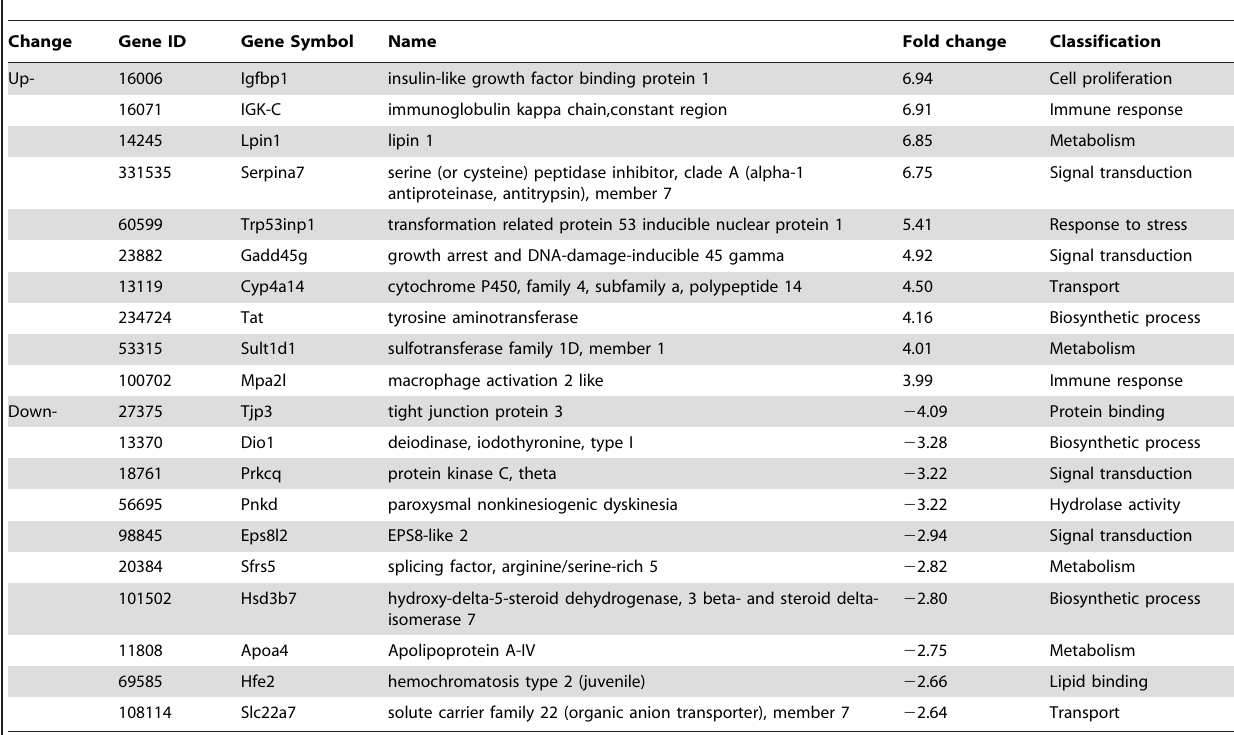
Table 3. Top 10 up- or down-regulated differentially expressed genes and their GO clustering classification at 3 months after intrahepatic injection of E.multilocularis metacestode (infected mice), compared to intrahepatic injection of saline (non-infected